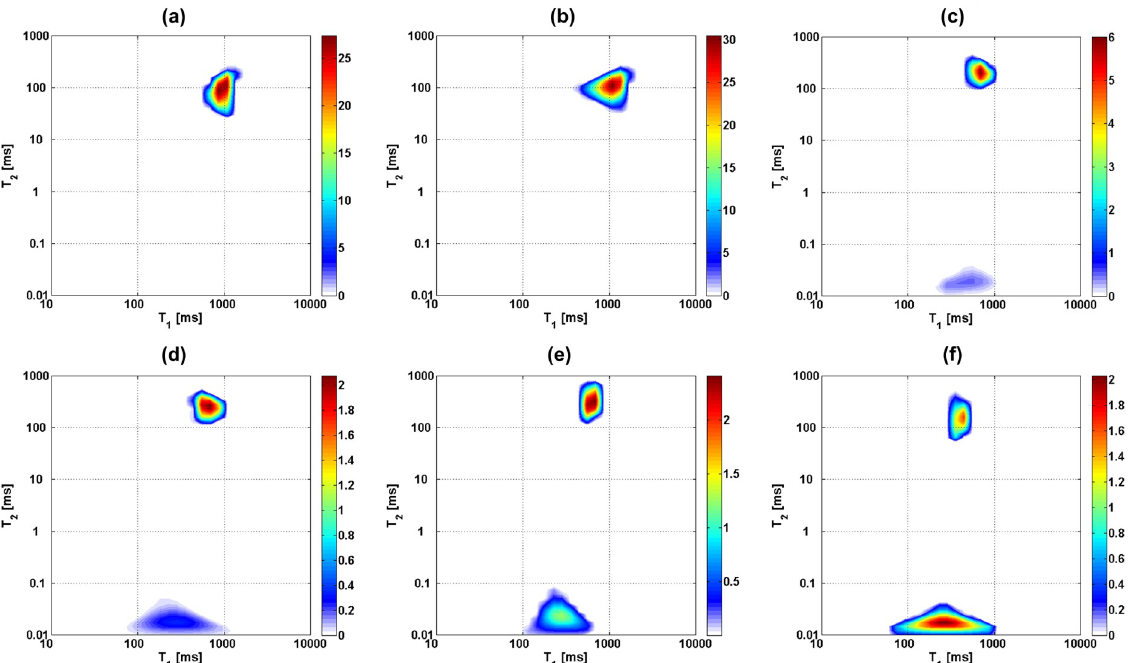
Fig 7. 1 H T 1 -T 2 maps of selected cartilage samples rehydrated with different PBS solutions containing H 2 O or D 2 O: a) original sample, 1Cw, b) sample dried and rehydrated with PBS solution prepared with 100% H 2 O, 2Cd0, c) sample rehydrated with PBS solution prepared with 80% D 2 O, 5Cd08, d) sample rehydrated with PBS solution prepared with 90% D 2 O, 8Cd09, e) sample rehydrated with PBS solution prepared with 100% D 2 O, 12Cd1, f) sample after trypsin treatment, dried and rehydrated with PBS solution prepared with 100% D 2 O, 6Td1. Note that the intensity of the secondary peak increases relative to that of the main peak as less light water (H 2 O) is included in the rehydrating solution.